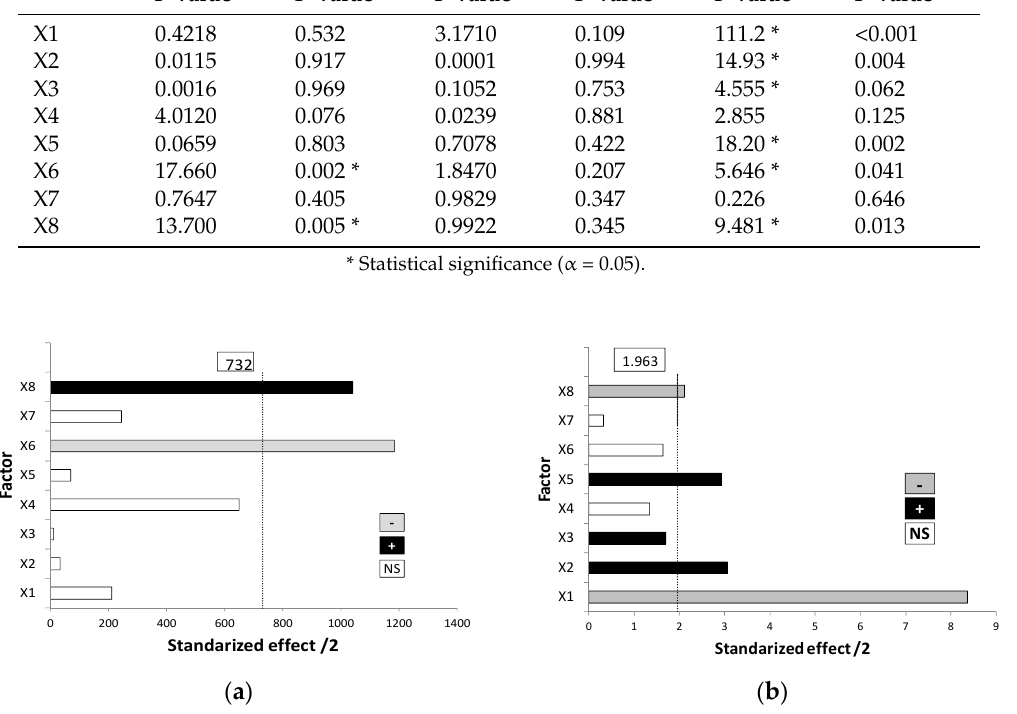
Figure 7. Pareto charts corresponding to: ( a ) Vesicle size. ( b ) Zeta potential. Pareto chart of the polydispersity index (PdI) is not shown because any factor was statistically significant. X1: Chems ( − 1 vs. +1); X2: DDAB ( − 1 vs. +1); X3: Cur ( − 1 vs. +1); X4: PL ( − 1 vs. +1); X5: Chems ( − 1, 1 vs. 0); X6: PL ( − 1, 1 vs. 0); X7: DDAB ( − 1, 1 vs. 0); X8: Cur ( − 1, 1 vs. 0).